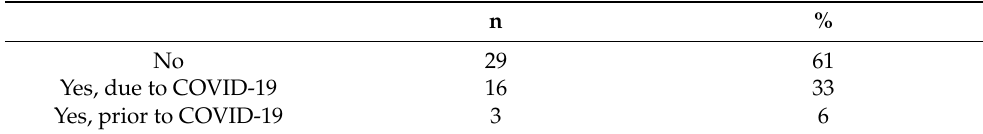
Table 12. Availability of Pre-Orders or